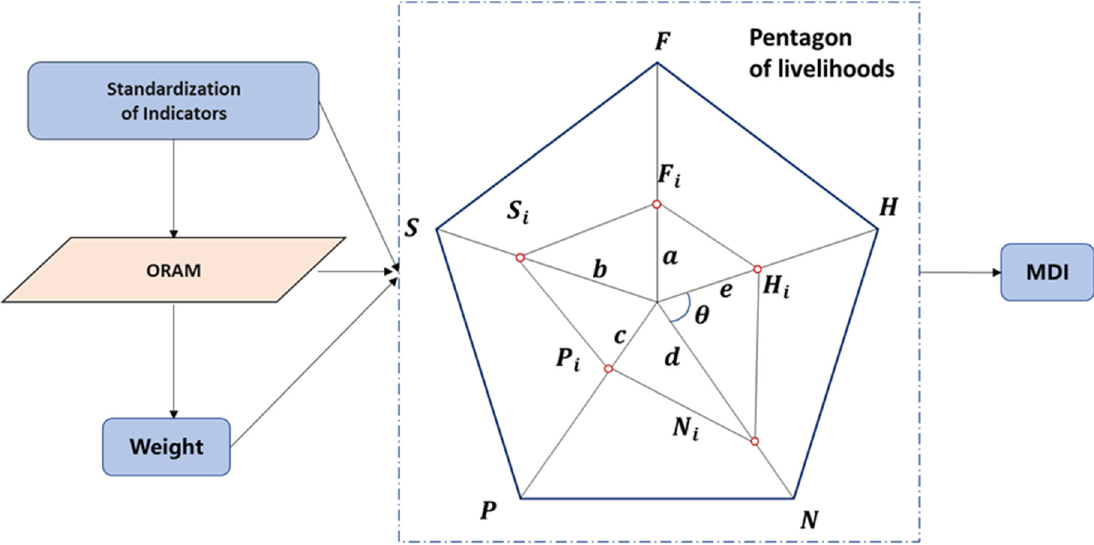
9 of 25 Table 5. Indicator system and weights for multidimensional poverty at the county level. Dimension